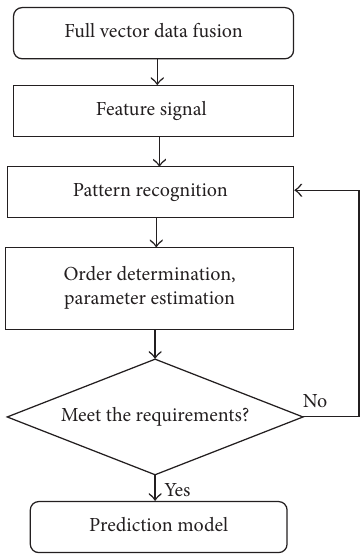
Figure 3: Process of prediction model establishment.